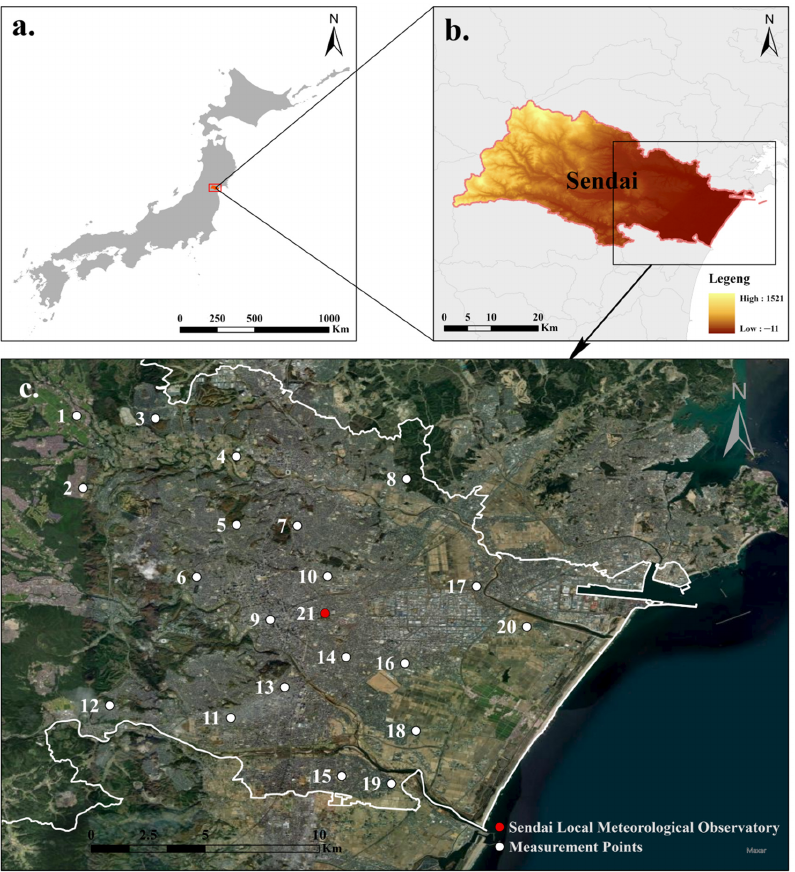
Figure 1. Map showing the location of Sendai and the distribution of temperature and humidity recorders and Sendai Local Meteorological Observatory in the study area. ( a ) Map of Japan; ( b ) topography of Sendai area; ( c ) distribution of temperature and humidity recorders on satellite maps.